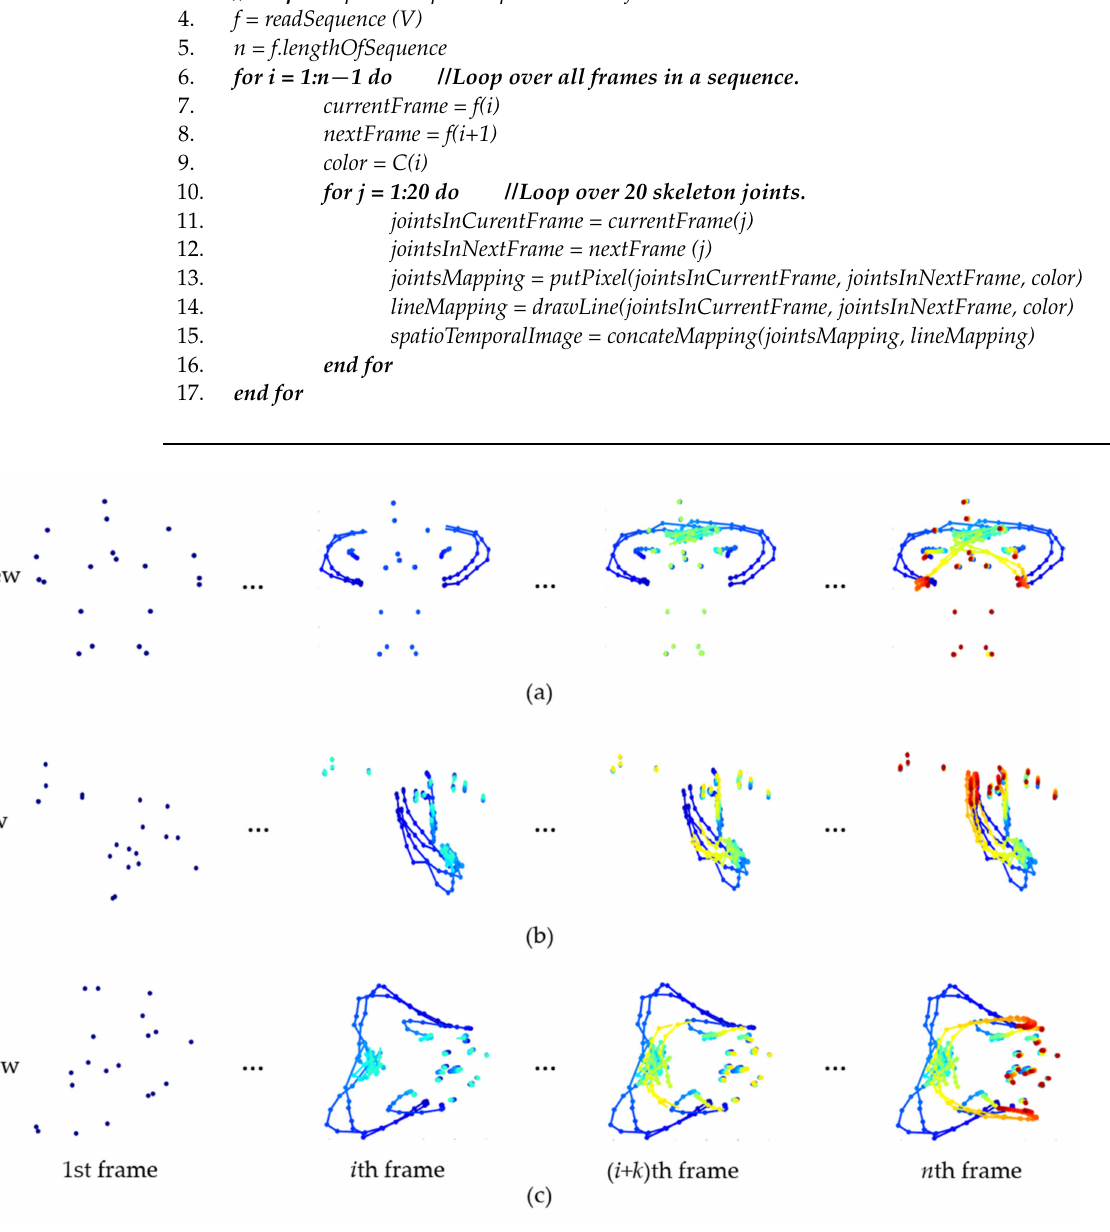
Figure 7. Spatio-temporal image formation (STIF) representation of ‘Clap’ action in UTD-MHAD dataset; ( a ) front view (along XY plane), ( b ) side view (along YZ plane), and ( c ) top view (along ZX